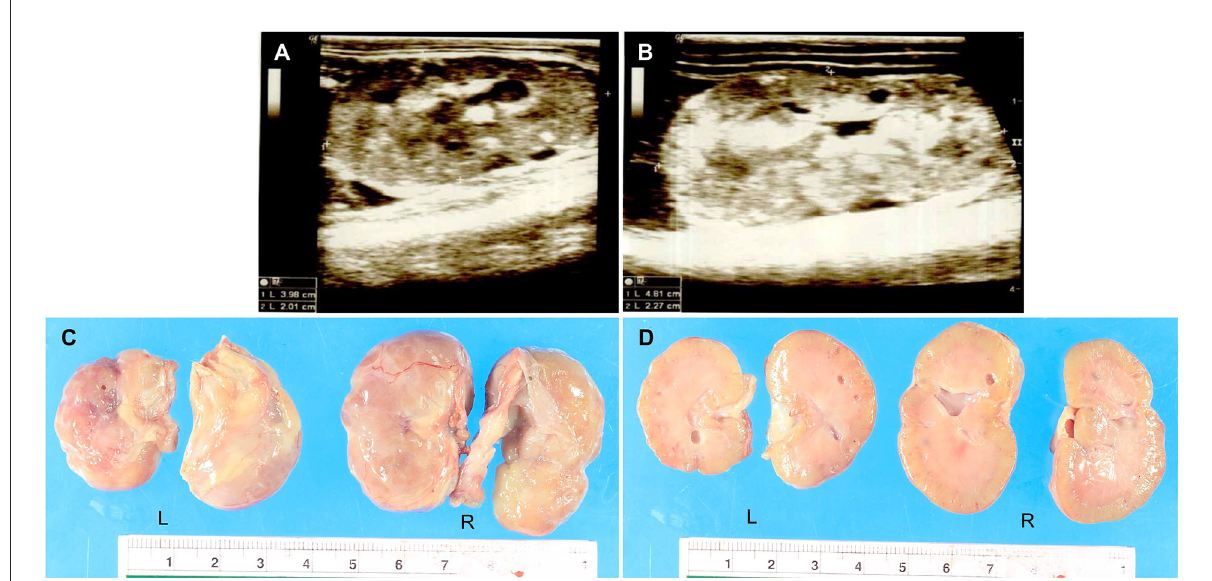
FIGURE1 (A,B) The ultrasonography report of the dysplastic kidneys. The results showed cystic formation and mineralization with ill-defined corticomedullary distinction and irregular margin. The size of the left kidney (3.98 × 2.01cm) (A) was smaller than the right kidney (4.81 × 2.27cm) (B) . (C,D) The macroscopic findings of the dysplastic kidneys were characterized by small irregular surfaces (C) . Multiple cysts showed in the renal parenchyma of both the left and right kidneys (D) . L = Left kidney, R = Right kidney.